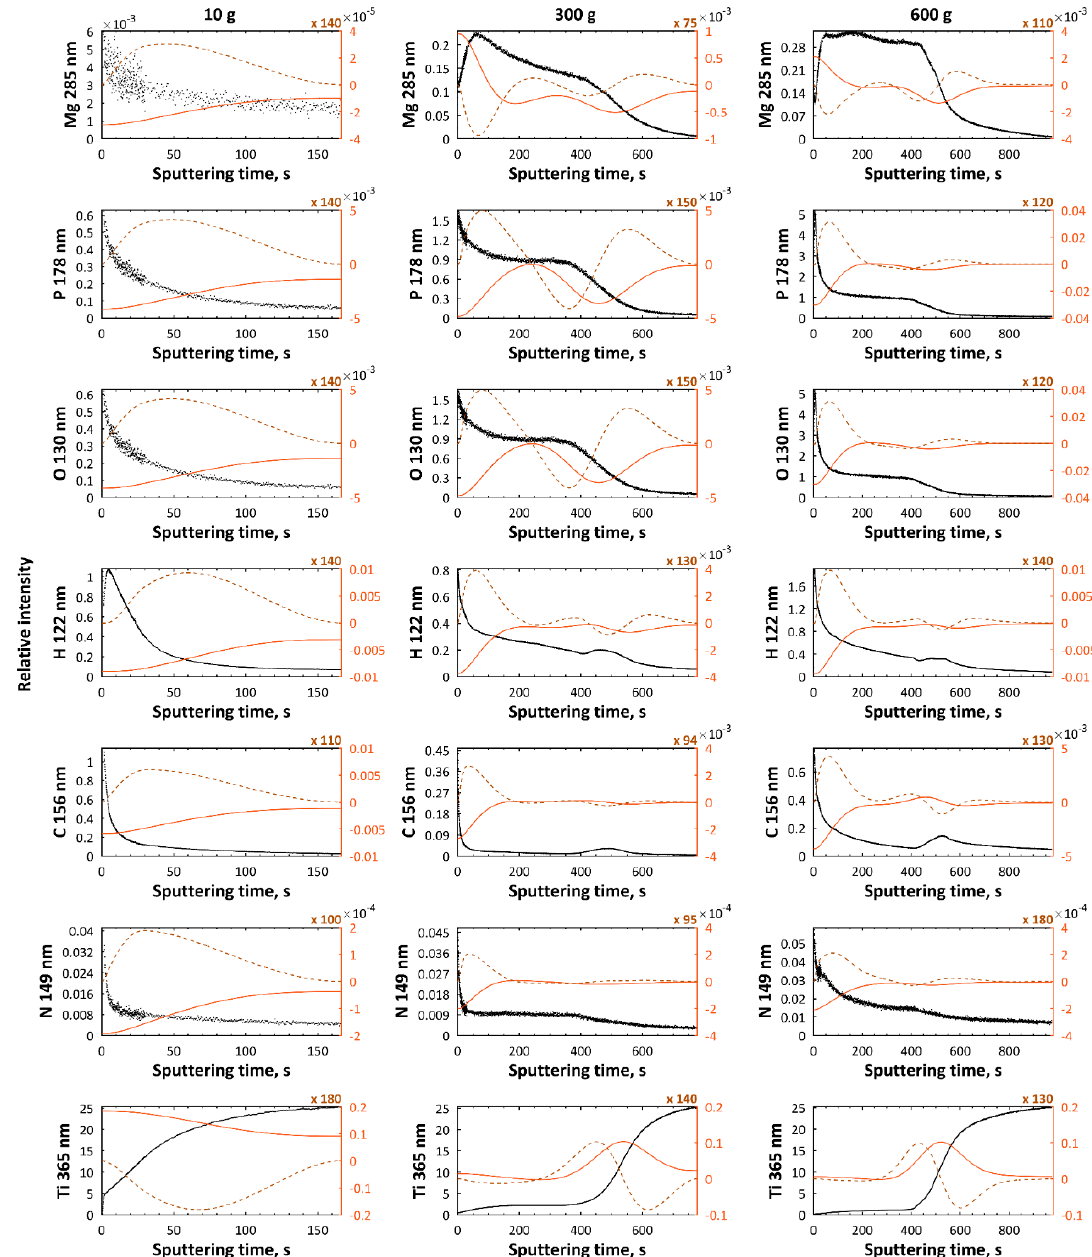
Figure 4. GDEOS signals (black) with first (red continuous line) and second (brown dashed line) derivatives for samples after PEO processing obtained in electrolyte composed of Mg(NO 3 ) 2 · 6H 2 O in H 3 PO 4 at concentrations of 10 g/L, 300 g/L, and 600 g/L, at a voltage of 450 ± 46 V, with a pulsation frequency of 300 Hz.